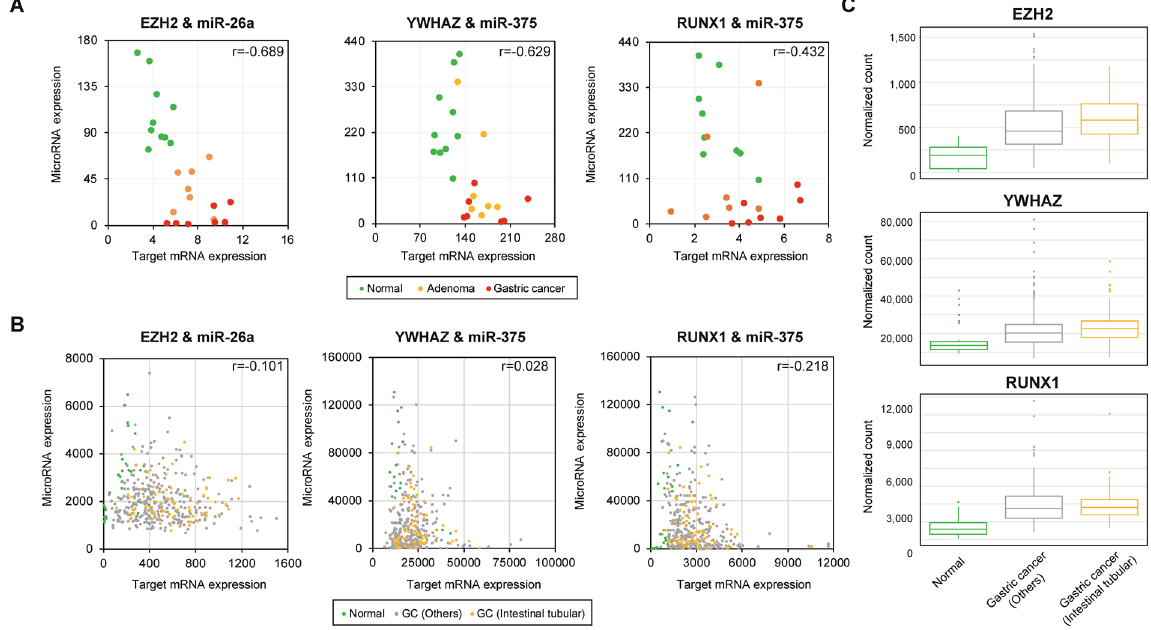
Figure 3. Spearman’s correlation between miRNA and well-known target genes in samples from normal, LGD, HGD, and EGC. ( A ) Negative correlation between miR-26a and EZH2 ( *** P = 2.87E-4, r = -0.689). Negative correlation between miR-375 and YWHAZ ( * P = 1.28E − 3, r = − 629) and RUNX1 ( * P = 3.61E − 2, r = − 0.432) in microarray data. ( B ) Negative correlation between miR-26a and EZH2 ( * P = 2.18E-2, r = -0.101). Negative correlation between miR-375 and YWHAZ (P = 0.288, r = 0.028) and RUNX1 ( *** P = 5.00E-6, r = -0.218) observed in TCGA data. ( C ) Expression of miRNA and their target gene mRNA expression patterns in TCGA